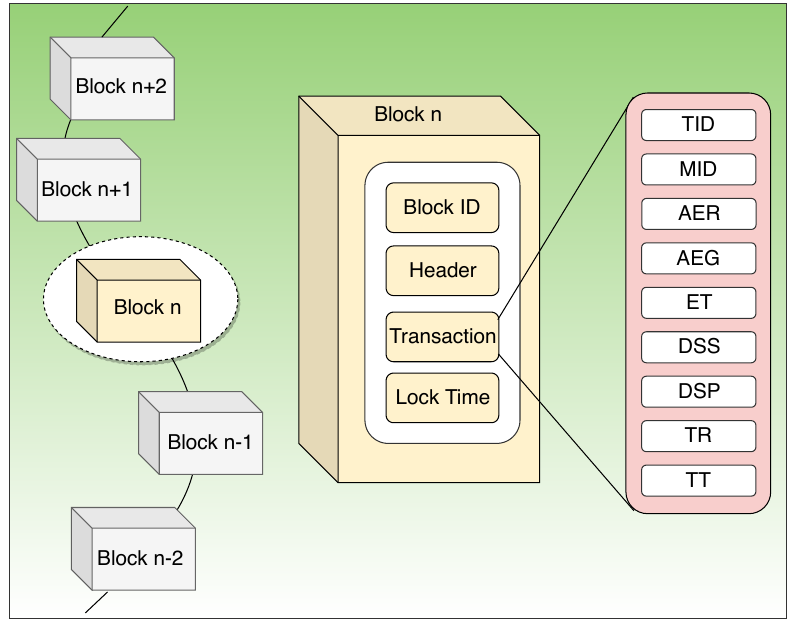
Figure 4. Block structure for P2P energy